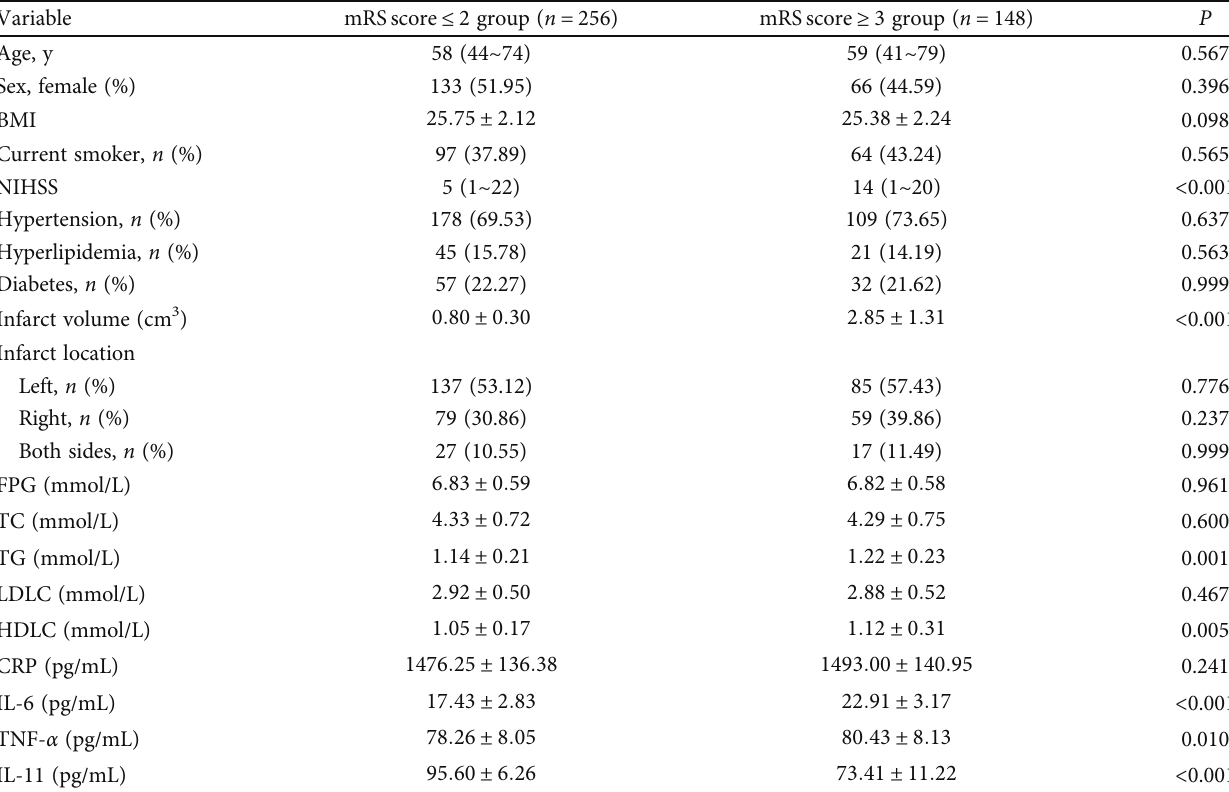
Table 3: Serum IL-11 levels and clinical data in ischemic stroke patients with di ff erent prognoses. Variable